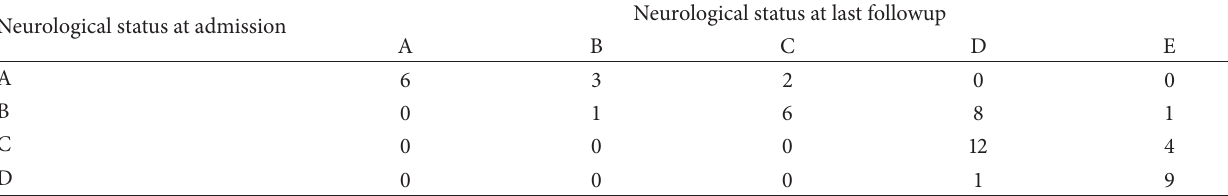
Table 2: The neurological recovery of 53 patients with thoracolumbar burst